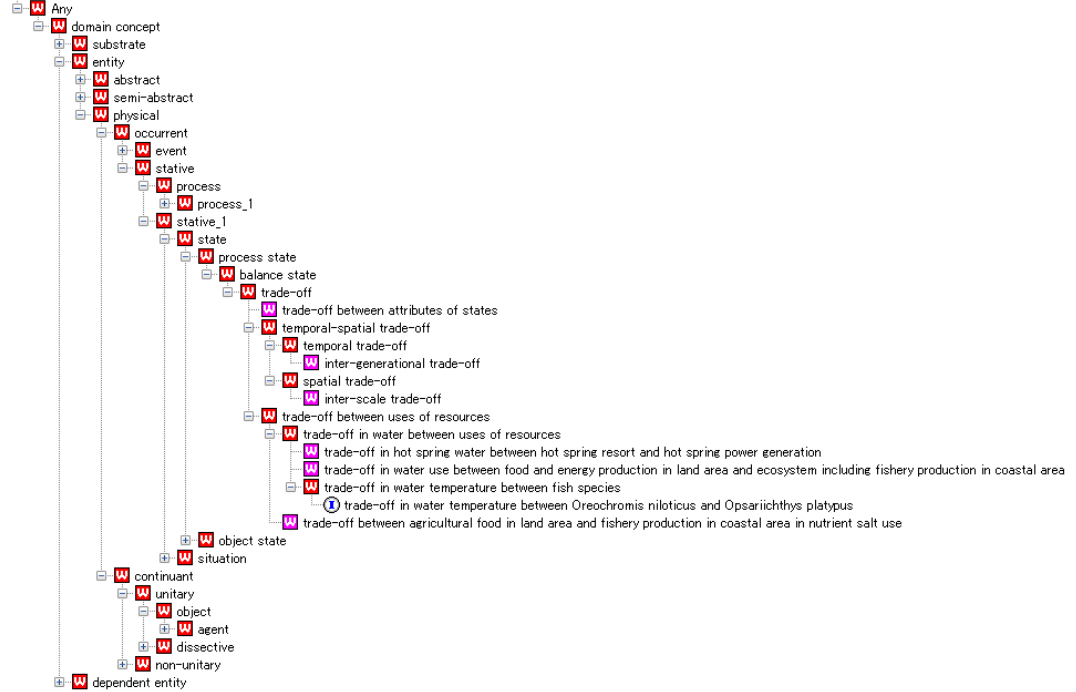
Figure 4. The concept tree of the top ‐ level ontology, including trade ‐ off related concepts, in the nexus domain ontology.